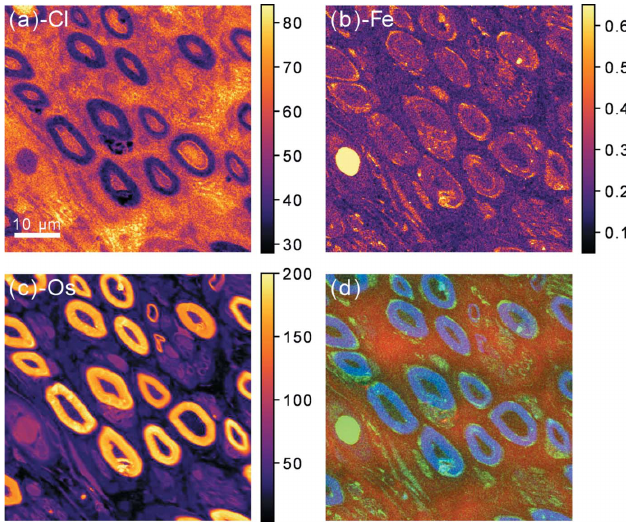
Figure 4 ( a )–( c ) Area mass density maps obtained via nanoscale X-ray fluorescence emission spectroscopy for ( a ) Cl, ( b ) Fe and ( c ) Os within a ROI of a section of an Os-stained human peripheral sural nerve biopsy from a healthy male. Linear intensity scales are shown in units of ng mm (cid:5) 2 . ( d ) RGB representation of the same region including electron density information from the holography scan: red, green and blue channels represent electron density, Fe and Os area mass densities, respectively. A 10 m m scale bar for all images is given in ( a